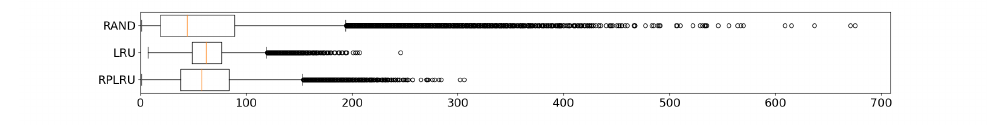
Figure 4: Distribution of the number of TLB misses until the eviction of the target address is achieved for random vs. LRU vs. RPLRU replacement policy. Simulated 4-way set-associative TLB with index randomization and 64 entries. 50 , 000 traces recorded for each